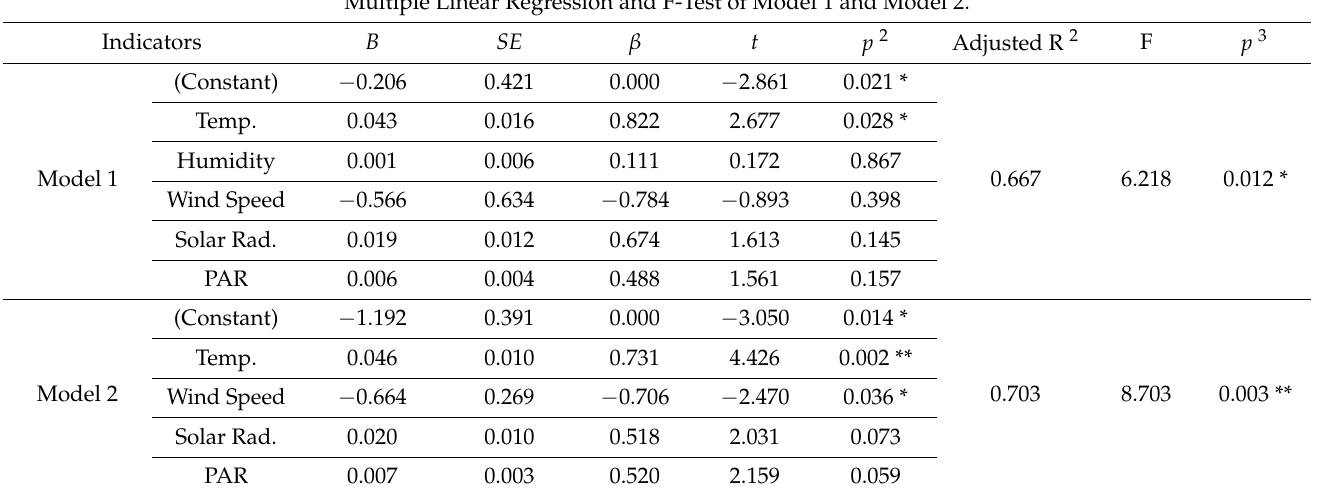
Table 7. Results of regression analysis of experimental site (900 trees/ha). Multiple Linear Regression and F-Test of Model 1 and Model